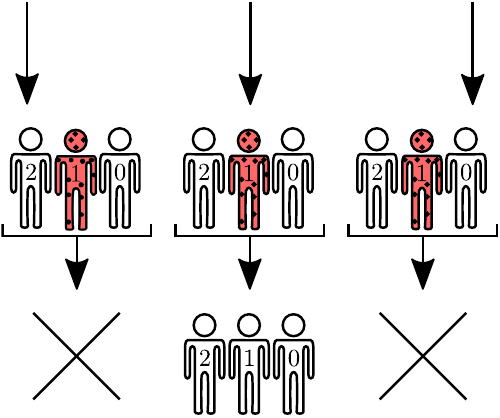
Figure 8. Recovery operator action on configuration vector | 2 (cid:105) , in the SIS model with N = 3. Non-vanishing transition is observed only for agent k = 1, which is infected, producing | 0 (cid:105)